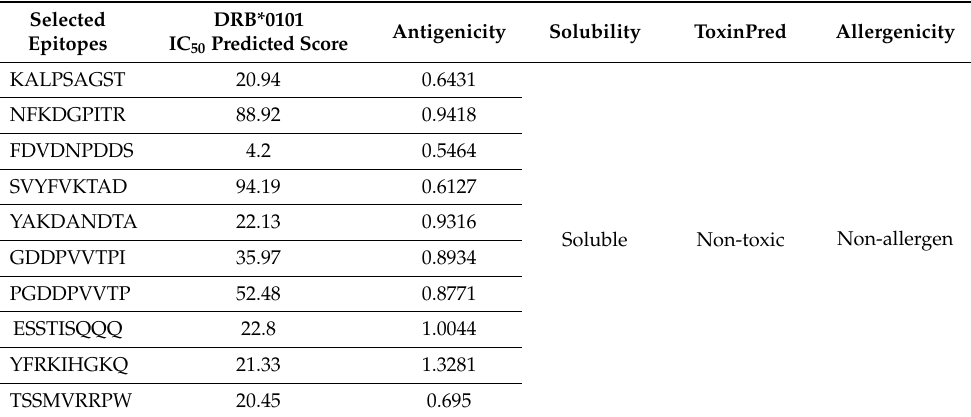
Table 2. List of probable antigenic, good water-soluble, non-toxigenic, and non-allergic DRB*0101 binding affinity